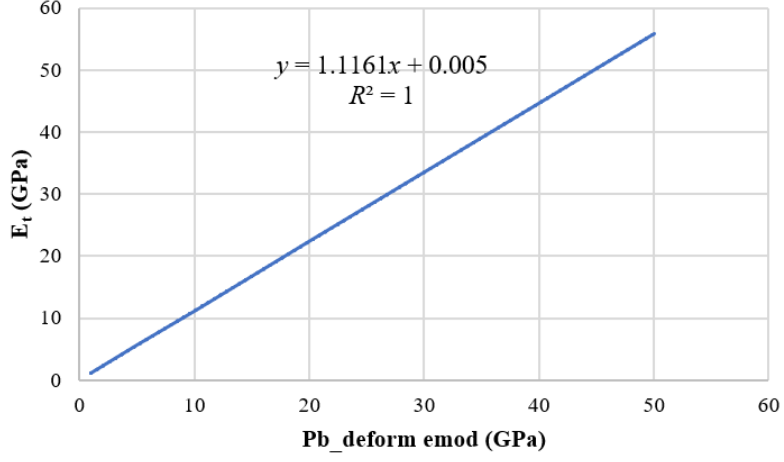
Figure 7. Correspondence between tensile modulus of elasticity and Pb_deform emo.